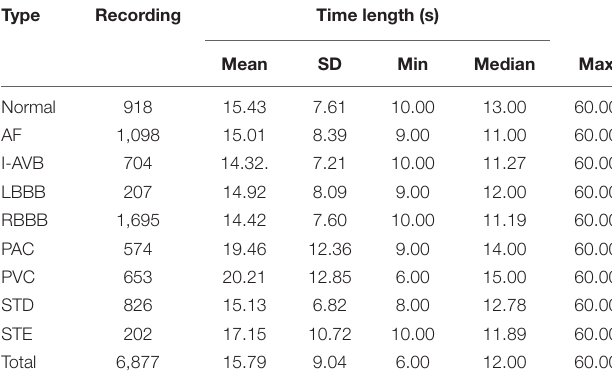
TABLE 1 | Data profile for the ECG dataset.